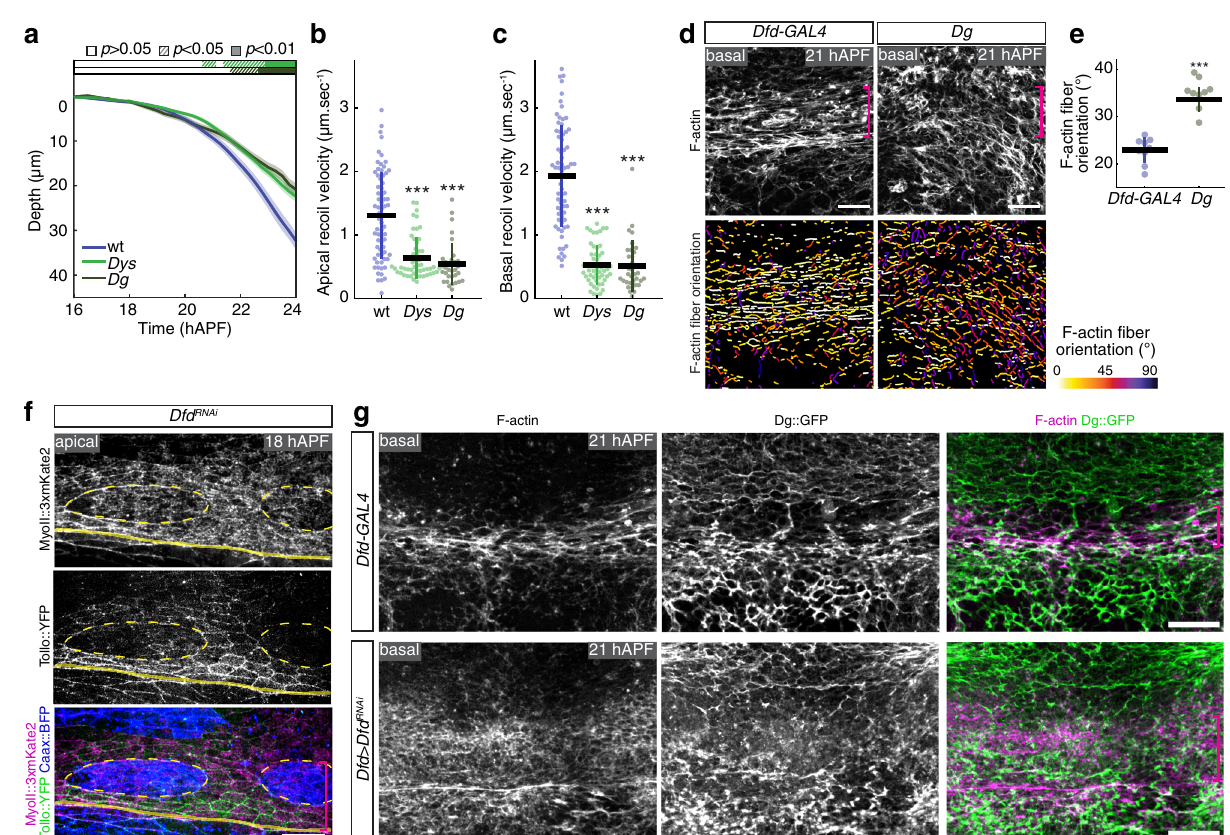
Fig. 4 | Control of ML in-plane tissue tension by Dys/Dg during neck folding. a Graph of the apical neck depth (mean±sem) in wt ( N =10 pupae), Dys ( N =12 pupae), and Dg ( N =10 pupae) tissues as a function of developmental time. Hor- izontal boxes: p -values of Welch tests performed between the experimental con- dition and the wt control at successive time points and color-coded according to theexperimentalcondition(white p >0.05,striped p <0.05,solid p <0.01). b Graph oftheMLapicalinitialrecoilvelocities(mean±sd)uponablationintheneckregion in wt ( N =69 pupae), Dys ( N =53 pupae, p =1.36e − 10) and Dg ( N =33 pupae, p =1.72e − 11) tissues. Ablations were performed at 20±2 hAPF. t -test, *** p <0.001. c Graph of the ML basal initial recoil velocities (mean±sd) upon ablation in the neck region in wt ( N =69 pupae), Dys ( N =53 pupae, p =4.54e − 23), and Dg ( N =33 pupae, p =9.13e − 21) tissues. Ablations were performed at 20±2 hAPF. d Basal F-actin distribution (top) and segmentation of the F-actin fi bers color-coded by orientation (bottom) at 21 hAPF in control Dfd-GAL4 and Dg tissues. Segmented F-actin fi bersarecoloredaccordingtotheirorientation,rangingfrom0°(alongthe